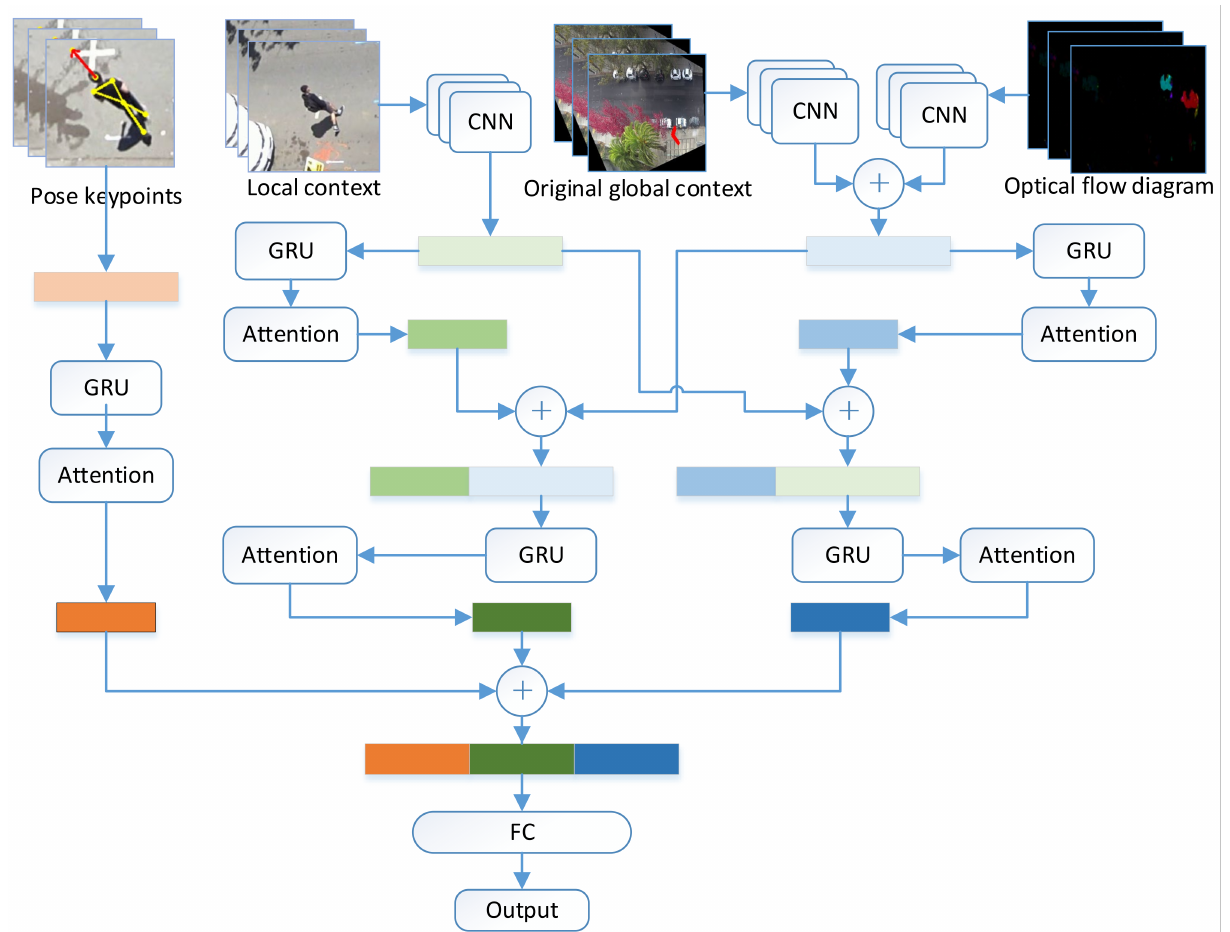
Figure 6. Overview of the proposed pedestrian crossing behavior prediction model. The model combines three feathers of pedestrian posture, local context and global context incorporating optical flow features. Pedestrian posture is coded by GRU, local context and global context are coded by cross-stacked GRU. Finally, the obtained features are connected and input to the fully connected layer for